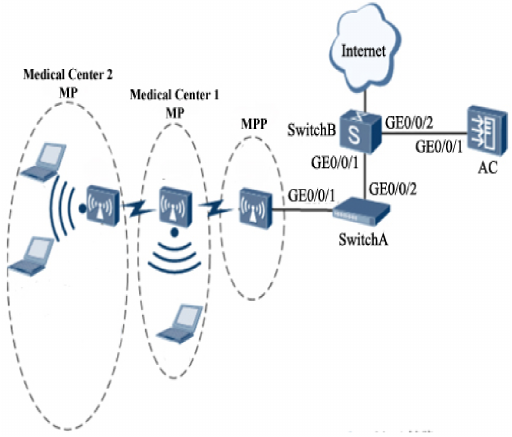
Figure 5. Suggested wireless mesh